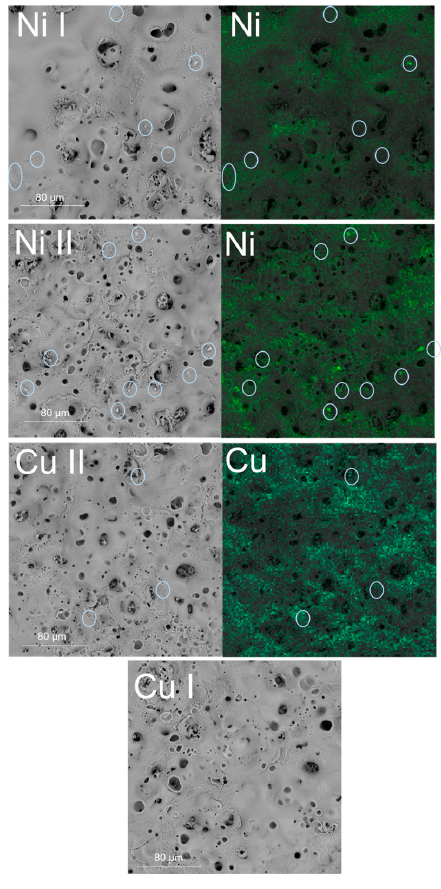
Figure 3. SEM images and EDX mapping of samples anodised in an electrolytic bath with Ni(OH) 2 and Cu(OH) 2 suspensions. Blue circles show dispersed particles on the surface of the layer.